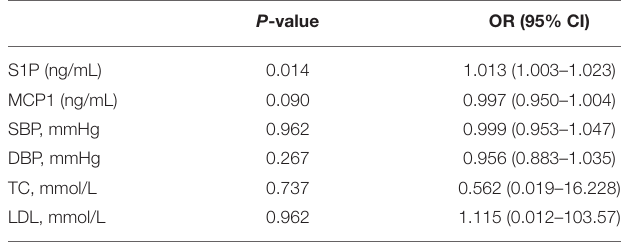
TABLE 3 | Logistic regression analysis of the association between S1P levels and cerebral collateral circulation (GCC vs. PCC). P -value OR (95%